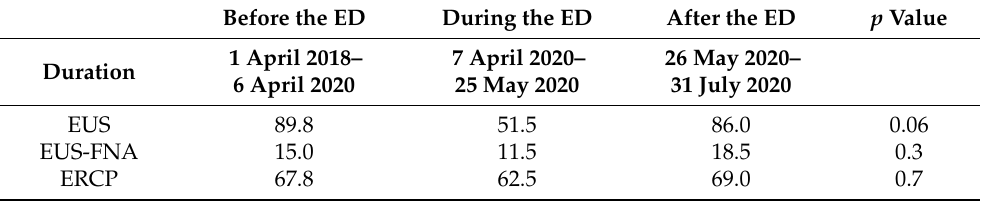
Table 3. The breakdown of ERCP during and post emergency declaration (monthly average). During the ED After the ED p Value Duration